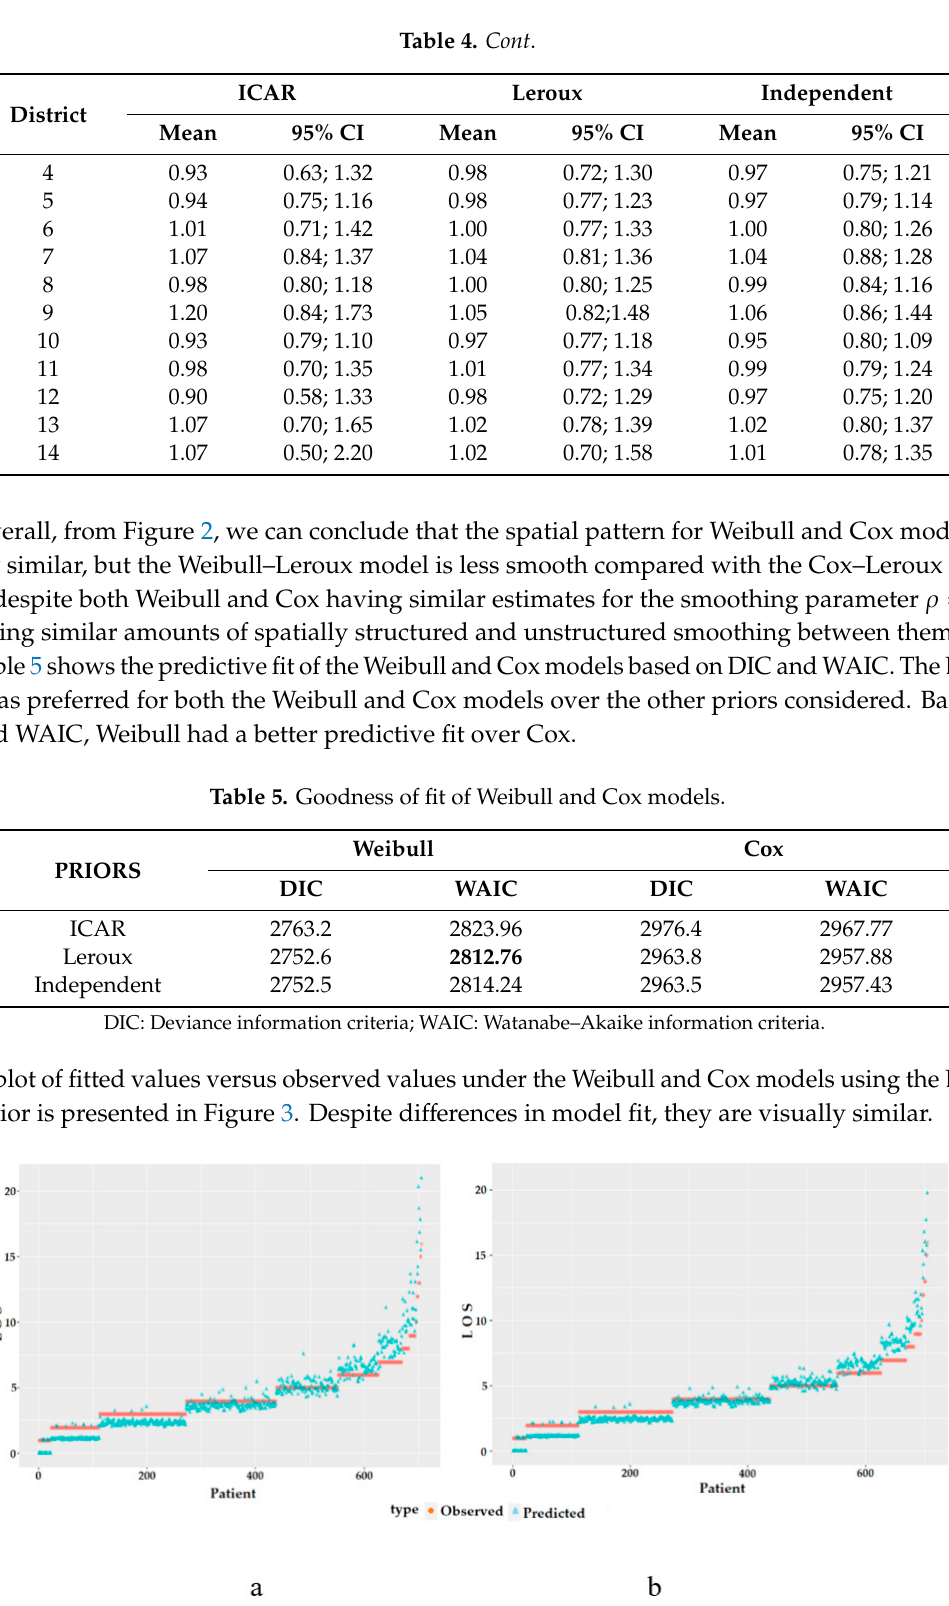
Figure 3. Plots of fitted values versus observed values of the ( a ) Weibull and ( b ) Cox models using